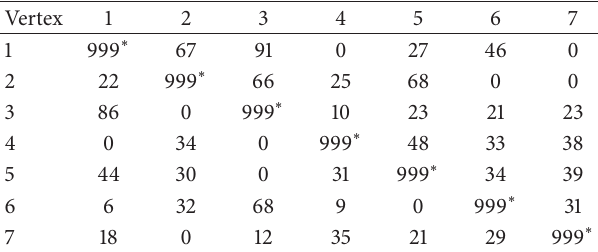
Table 2: The reduced cost